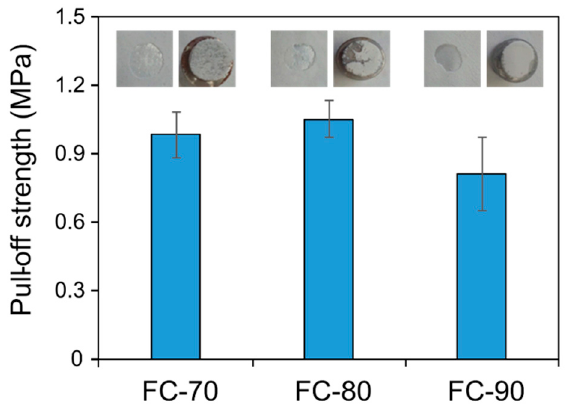
Figure 5. Pull-off adhesion strength for all composite coatings.